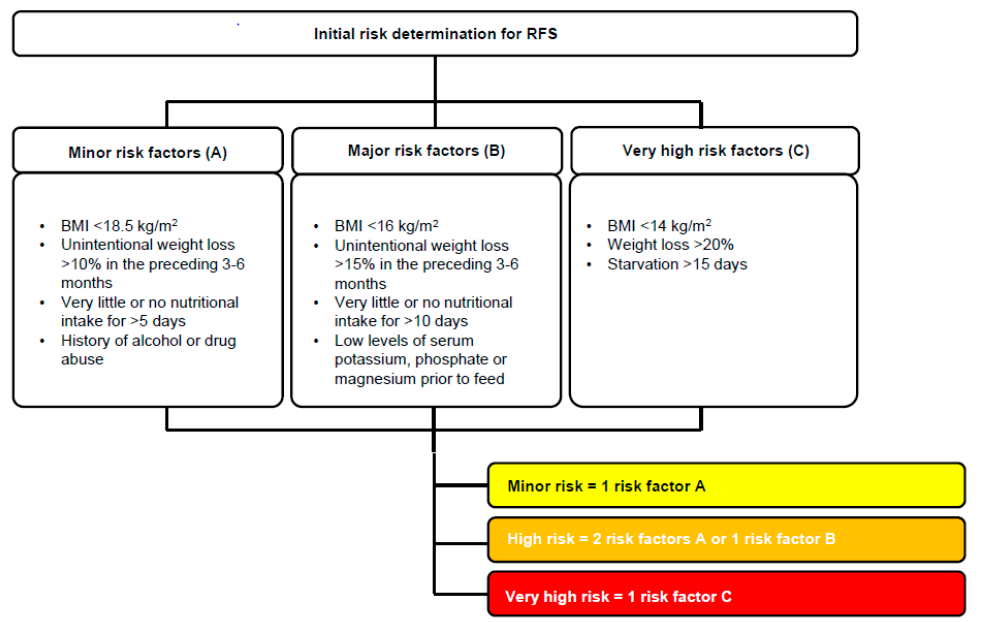
Figure 3. Risk stratification of refeeding syndrome. Reprint with permission from Ref. [24]. 2017, Division of Diabetes, Endocrinology, Nutritional Medicine and Metabolism, University Hospital, Bern.